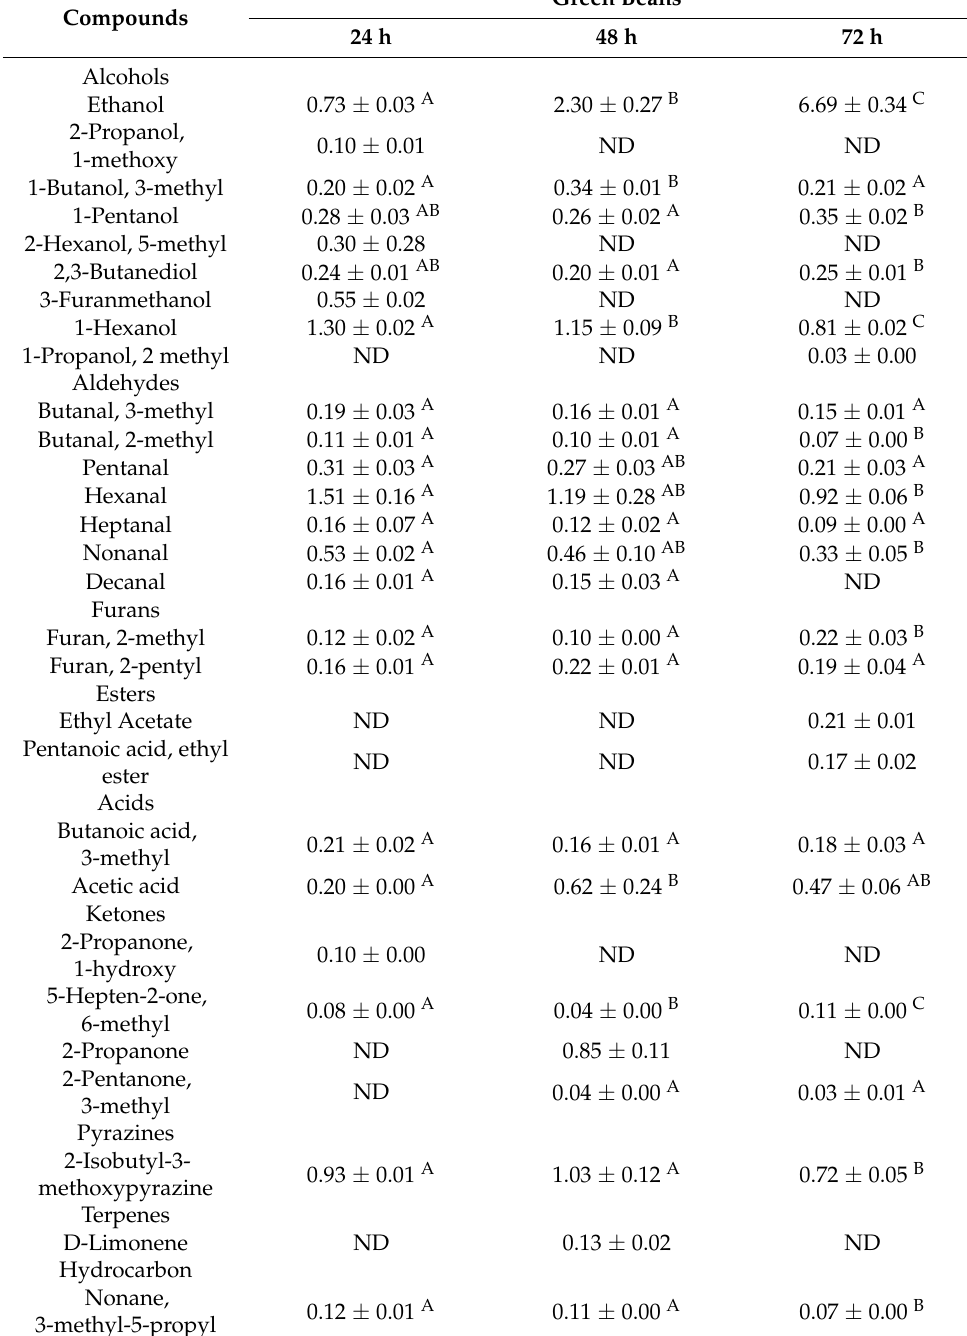
Table 3. Volatile compounds (area × 10 5 ) identified in fermented green coffee